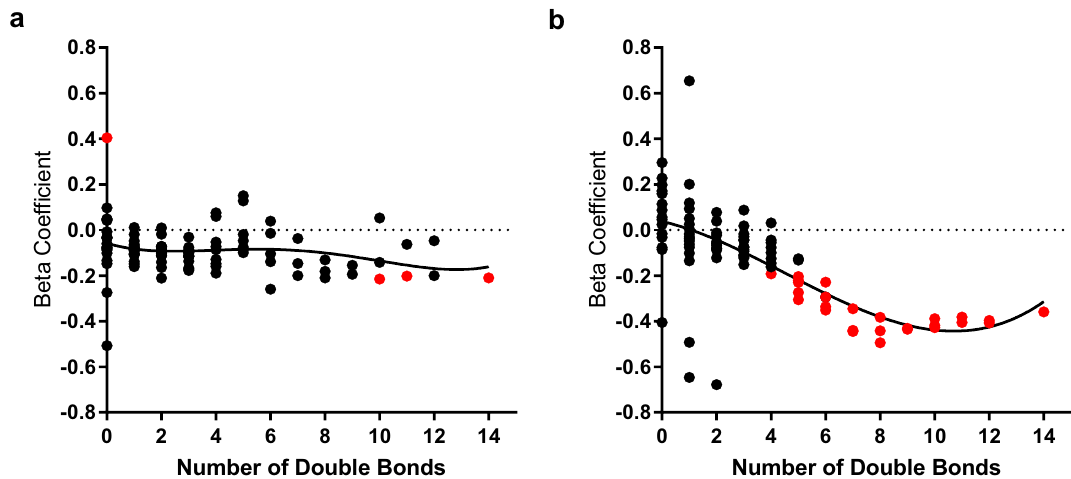
Figure 5. Association between triglycerides and birth weight in male and female infants. Regression models estimated the linear relationship between cord blood individual triglycerides and Fenton BW z score in ( a ) males and ( b ) females, adjusting for maternal age, parity, gestational age, baseline BMI, and GWG. Beta coefficients are plotted by the number of double bonds in the fatty acid tails of the TGs. Significant TGs are marked in red (α = 0.05). Non-parametric regression fit polynomial lines for each